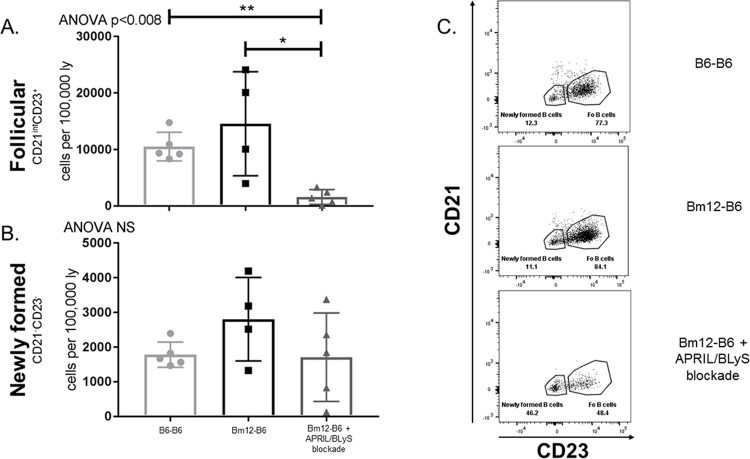
Follicular B lymphocytes were significantly depleted with APRIL/BLyS blockade, but newly formed B cells remained unchanged.Flow cytometry was used to assess immature and mature B lymphocyte populations in spleen. Each graph shows number of cells per 100,000 lymphocytes. (A) Follicular B lymphocytes were defined as CD3-CD21intCD23+. (B) Newly formed B cells were identified as CD3-CD21-CD23-. (C) Representative flow cytometry data of follicular and newly formed B cells by group. Number shown represents percentage of total cells in gate. *p<0.05, **p<0.008.